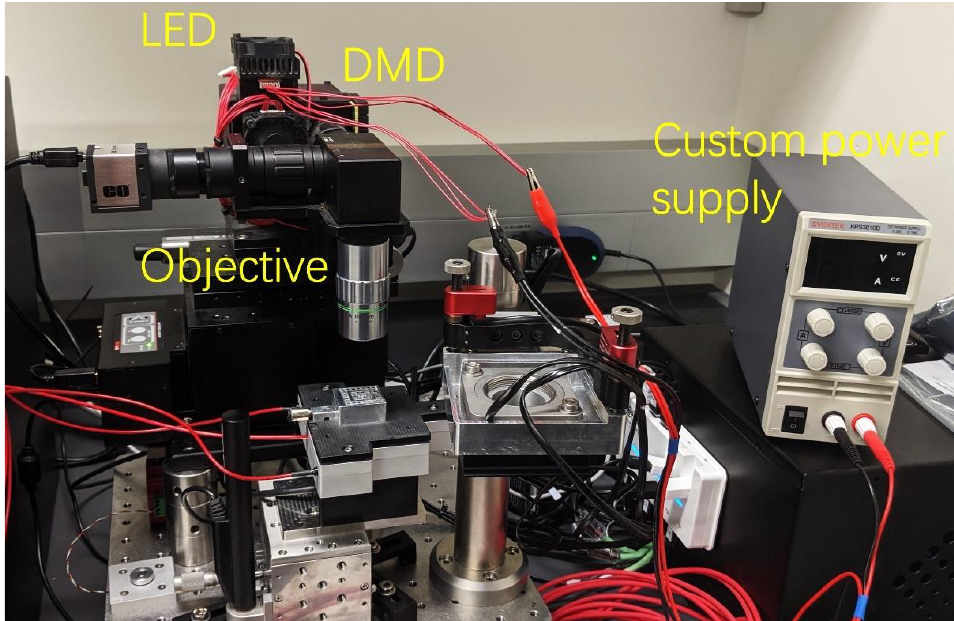
Figure 4. Photograph of the molecular printer featuring local high-power illumination capability. Key components are labeled, including the LED, DMD mirror, objective and a custom power supply supporting high-current operation of the LED.